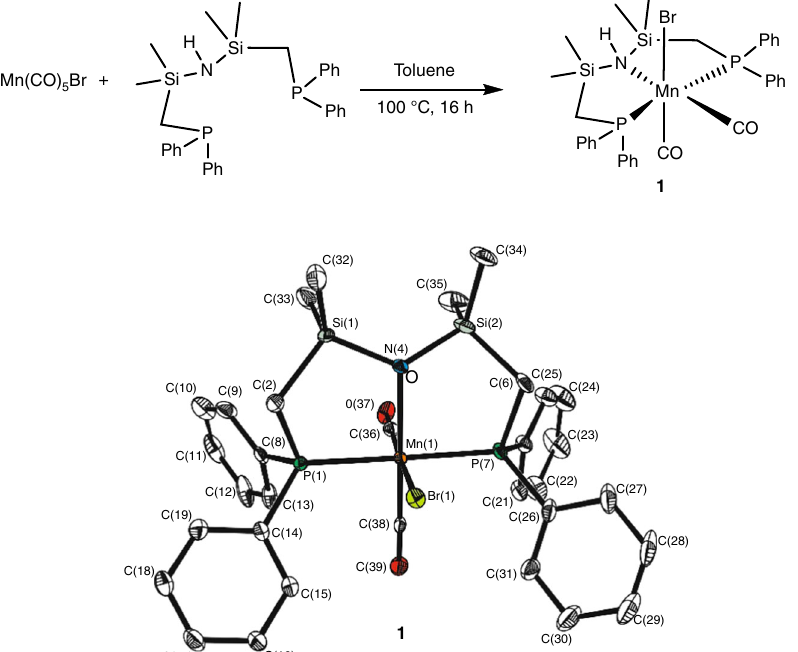
Fig. 1 Reaction scheme and molecular structure of complex 1 . Overall geometry: distorted octahedral. Selected angles and atom distances: [P(1)-Mn(1)-P (7) = 173.47°], [C(36)-Mn(1)-C(38) = 86.14°]. The Mn center is embedded in the P,N,P-pincer framework with bond lengths in the typical range [(Mn(1)- P(1) = 229.97 pm; Mn(1)-N(4) = 227.4 pm; Mn(1)-P(7) = 230.22 pm), (Si(1)-N(4) = 177.0 pm), (N(4)-Si(2) = 177.1 pm)]; and both P-Mn-N angles very close to 90° (P(1): 88.32° and P(7): 87.91°,